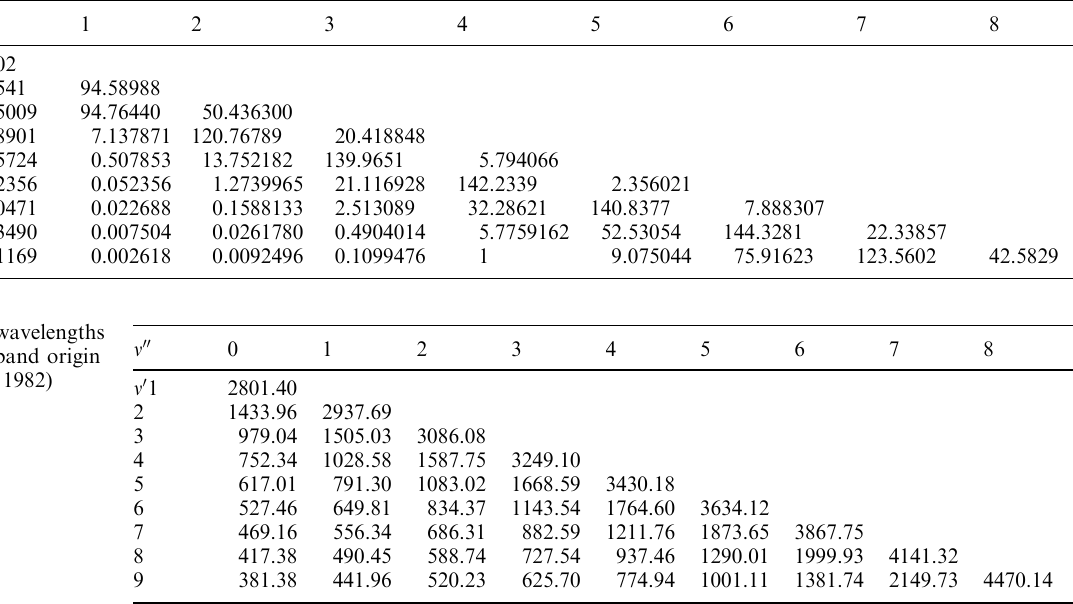
Table 1. Calculated relative band intensities I( (cid:109) 00 ; (cid:109) 0 )/I(9,4) using Llewellyn et al . (1978) (cid:109) 00 0 (cid:109) 0 1